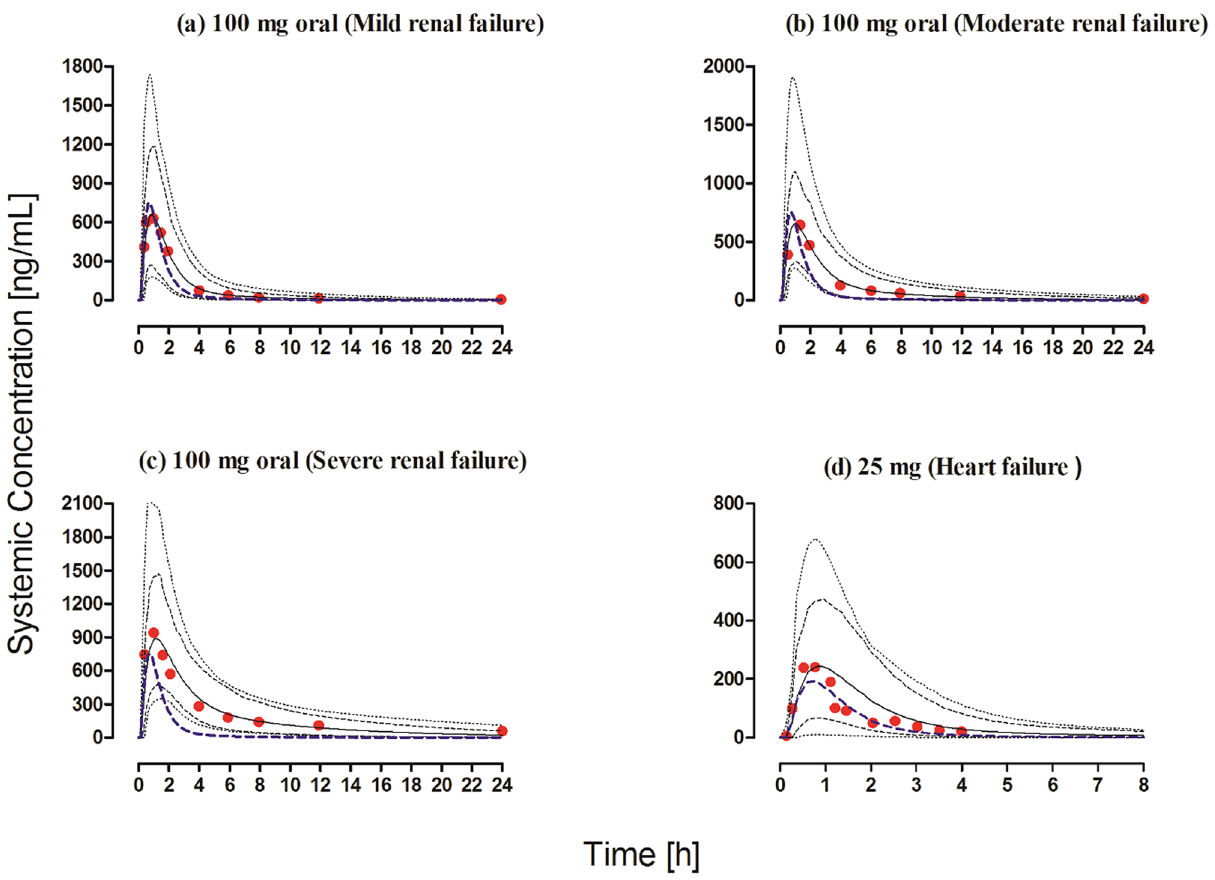
Figure 6. Observed and predicted systemic concentration profiles of captopril in disease populations after oral administration. ( a – c ) Mild, moderate, and severe CKD patients after 100 mg oral administration 27 . ( d ) Chronic heart failure patients after 25 mg oral administration 45 . The observed data are shown as (red circles). The predicted results are shown as mean (solid line), maximum value, and minimum value (dashed line) and the 5th–95th percentiles (dotted line). The blue dashed line shows the mean prediction in a healthy population after administering the same oral